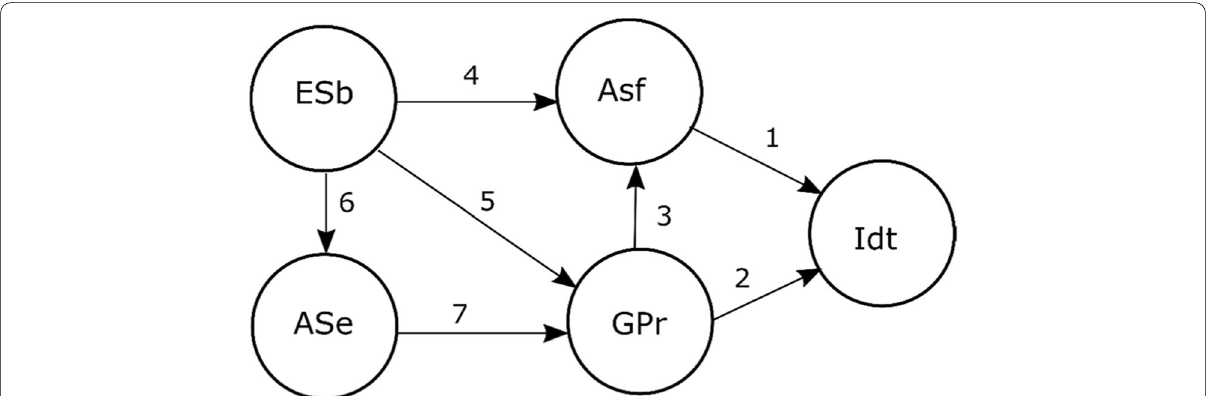
Fig. 1 Proposed model and paths. Note. ESb, environmental support and barriers; ASe, academic self-efficacy; ASf, academic satisfaction; GPr, goal progress; Idt, occupational